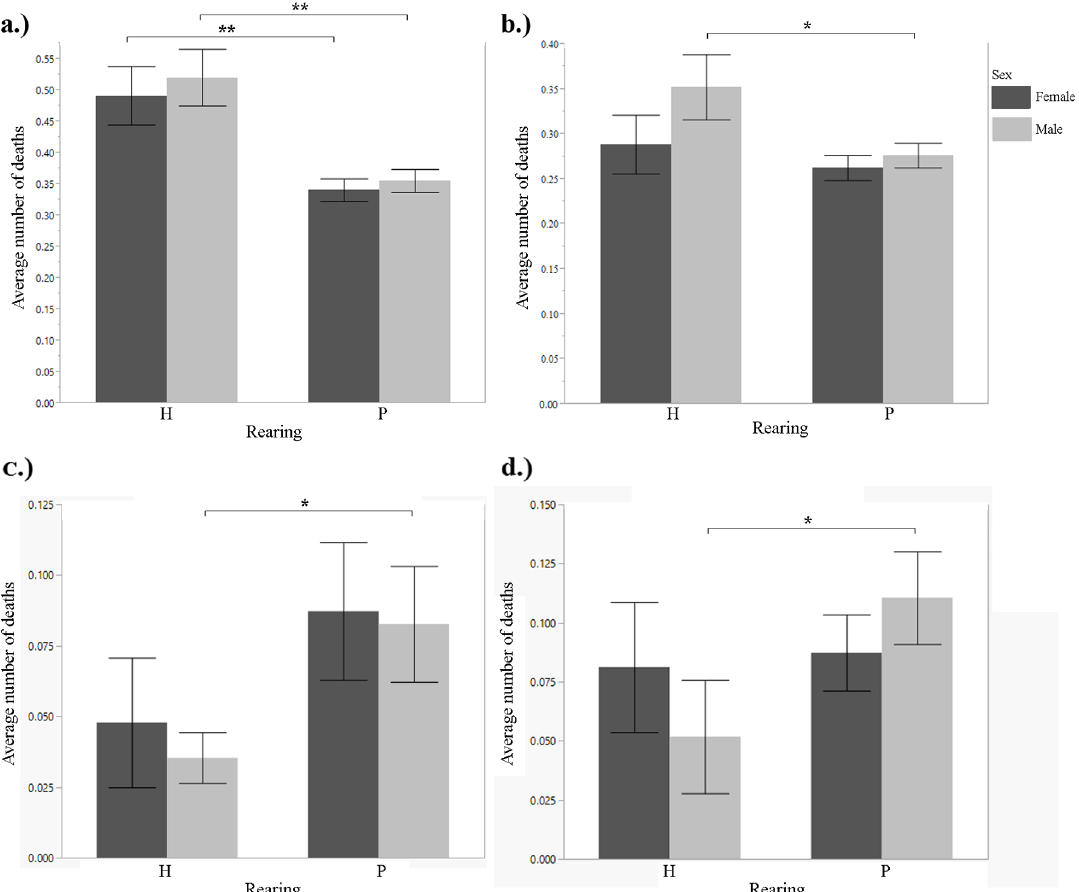
Fig 3. Mean occurrence of death before weaning age, by rearing type. A.) snow leopard (1901 – 2011) B.) cheetah (1901 – 2011) C.) Siberian tiger (2000 – 2011) D.) snow leopard (2000 – 2011). t-test: * p < 0.05; ** p <